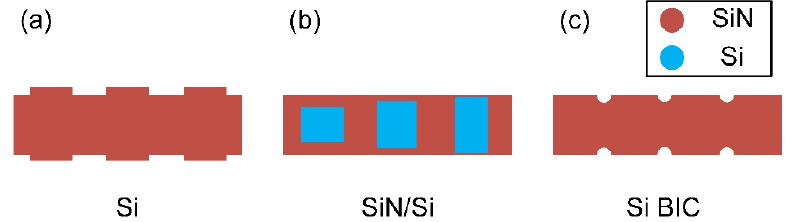
Figure 10. The schematic diagram of the ( a ) sidewall grating antenna; ( b ) SiN/Si grating antenna; ( c ) BIC-based silicon waveguide grating antenna.